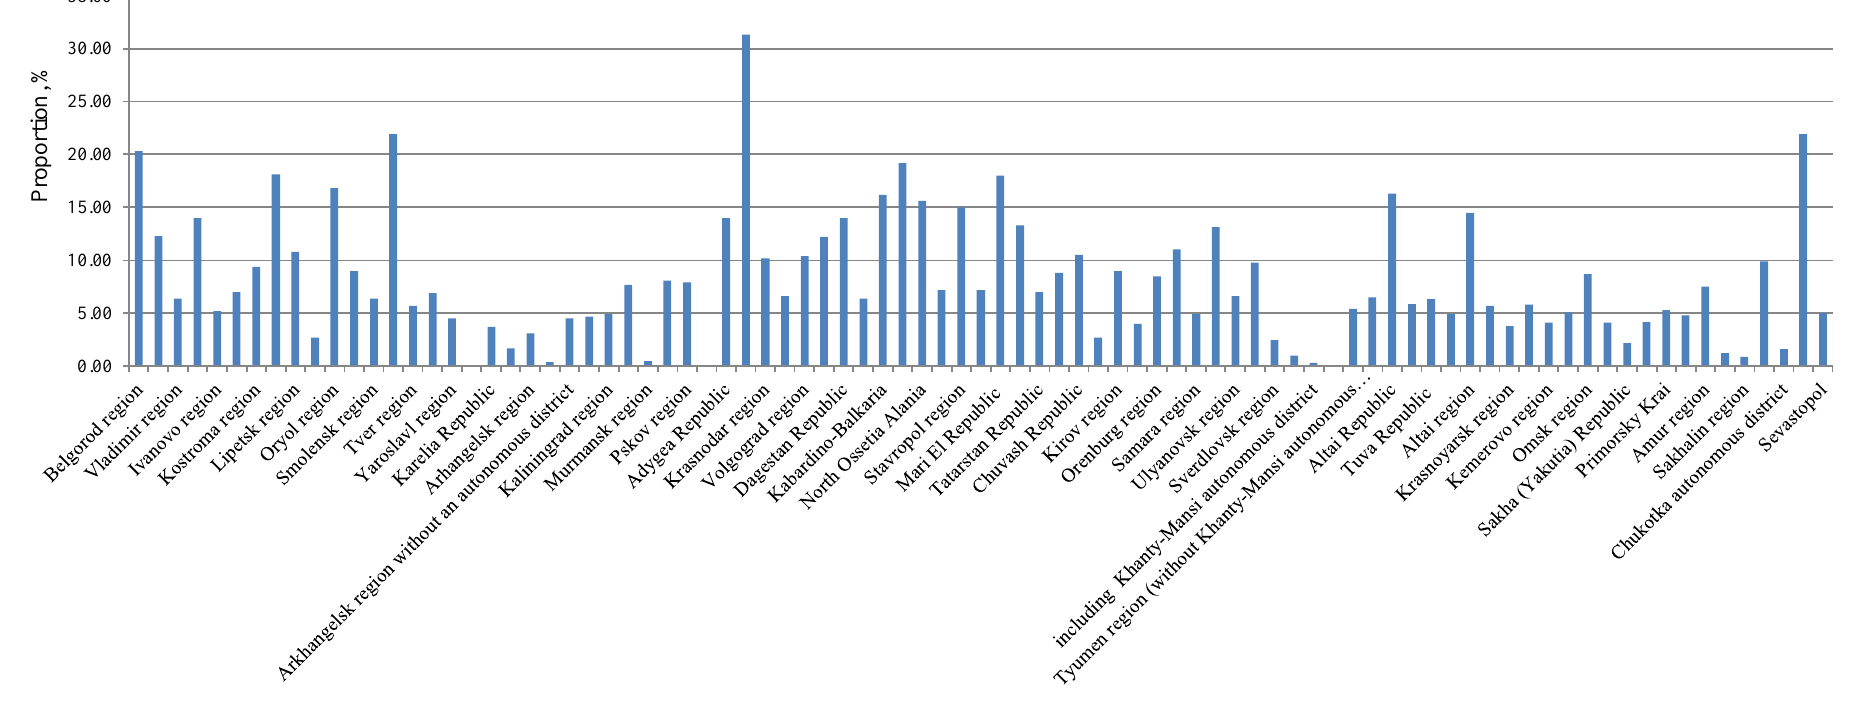
Fig. 1. Share of the "Agriculture, hunting and forestry" in the structure of regional GRP of the Russian Federation entities for 2014 (compiled by the authors to: [10]).